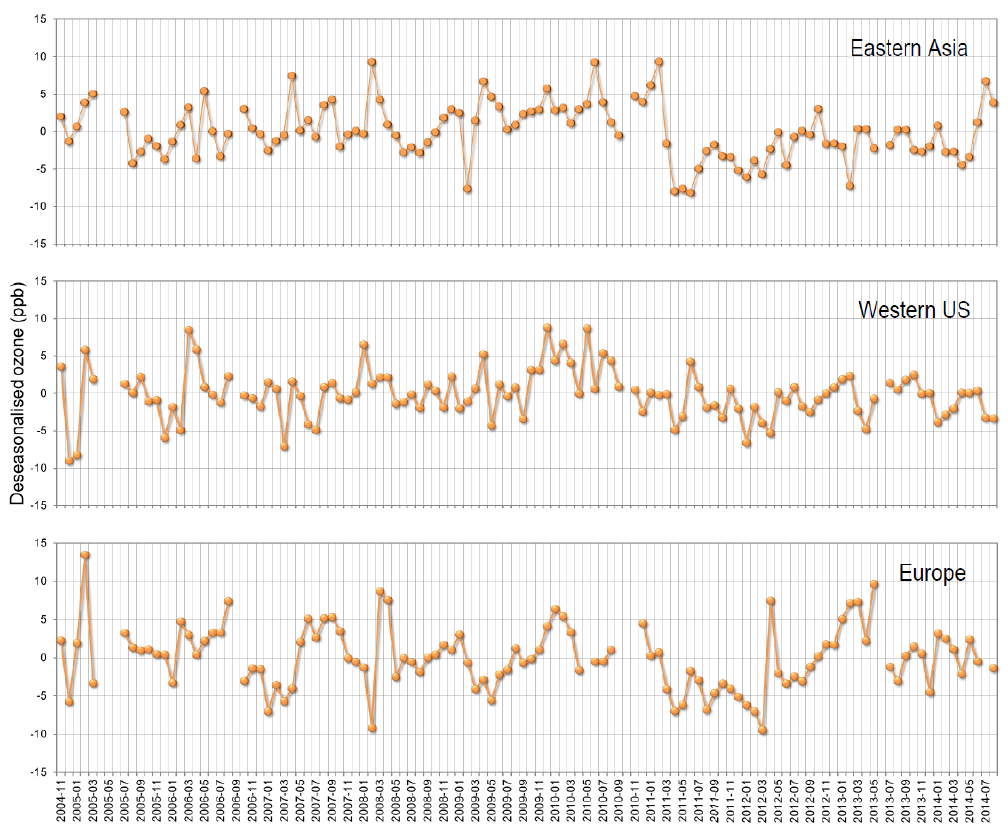
Figure 8. Deseasonalised joint time series for TES and IASI-TOE for the data from Fig. 7.